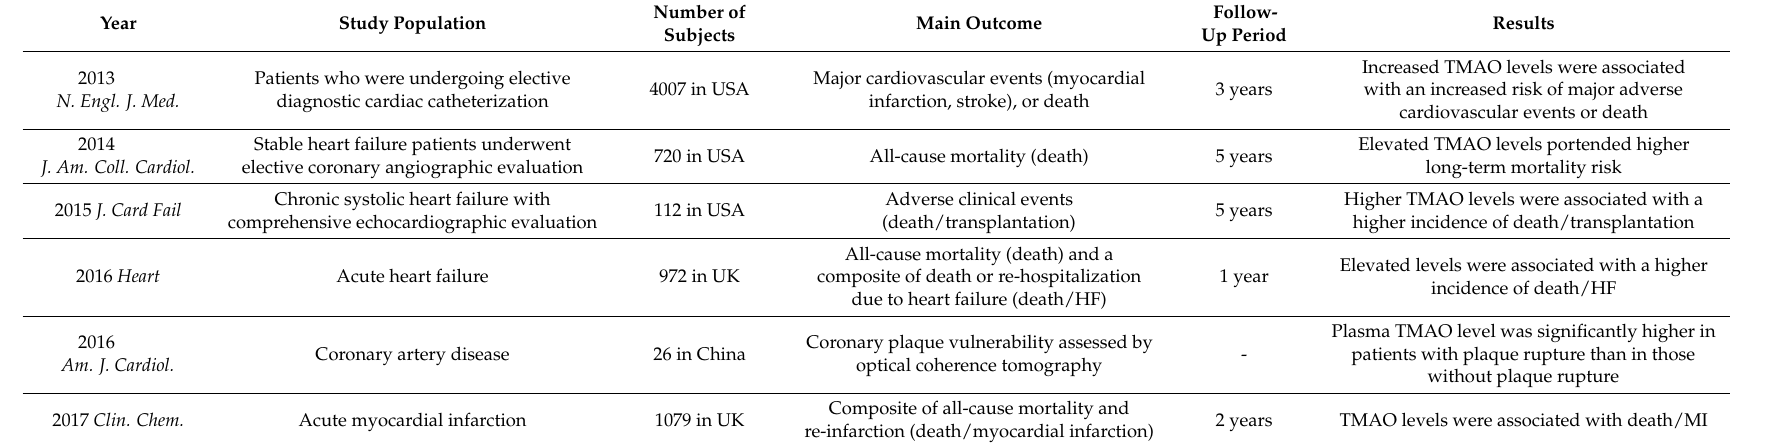
Table 1. Major clinical reports demonstrating the impact of circulating trimethylamine- N -oxide (TMAO) levels on cardiovascular diseases